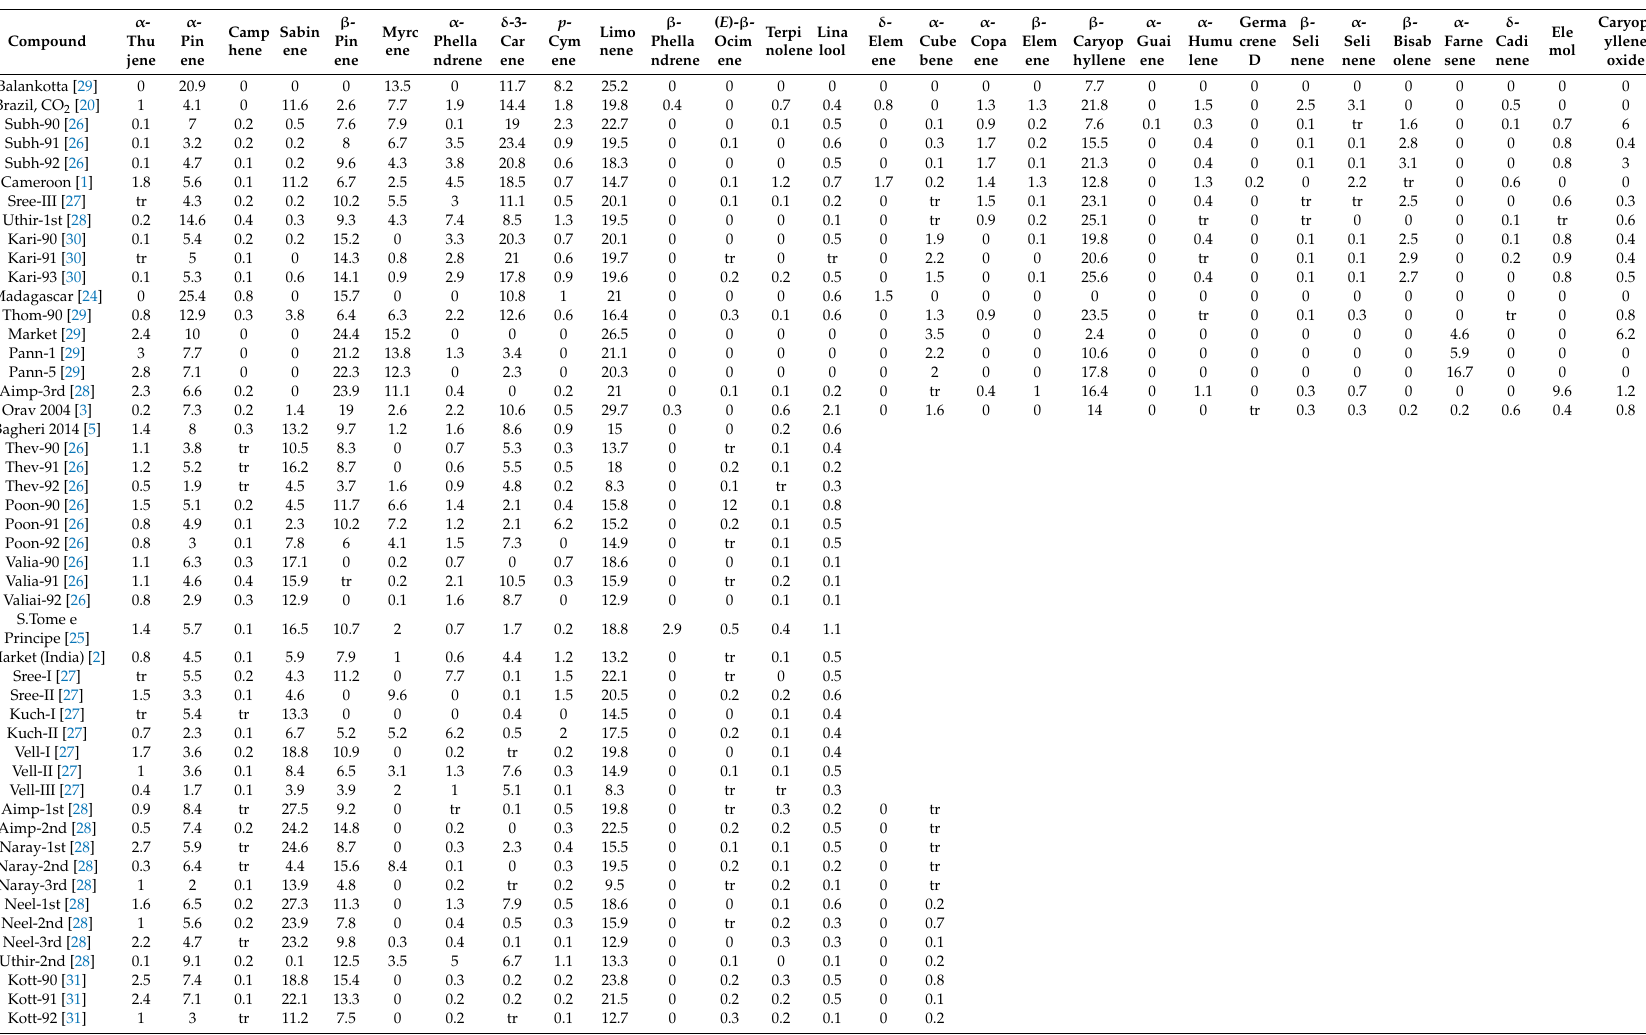
Table 3. Chemical compositions (major components, %) of Piper nigrum volatile oils reported in the